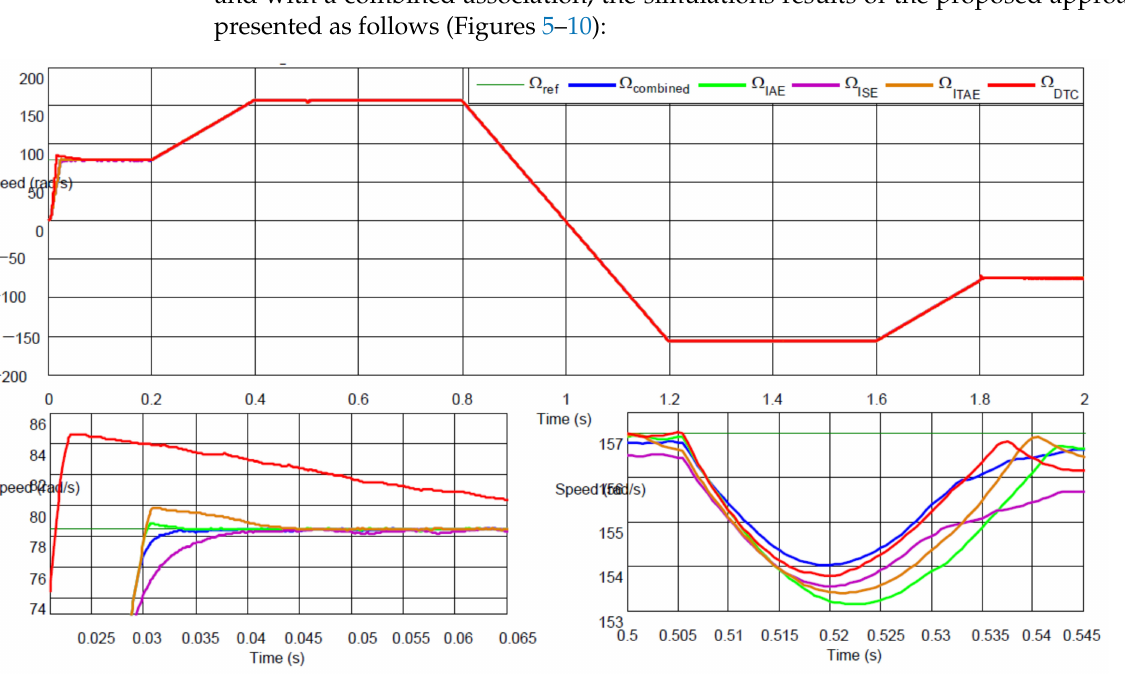
Figure 5. Speed responses of the DTC control without and with the objective